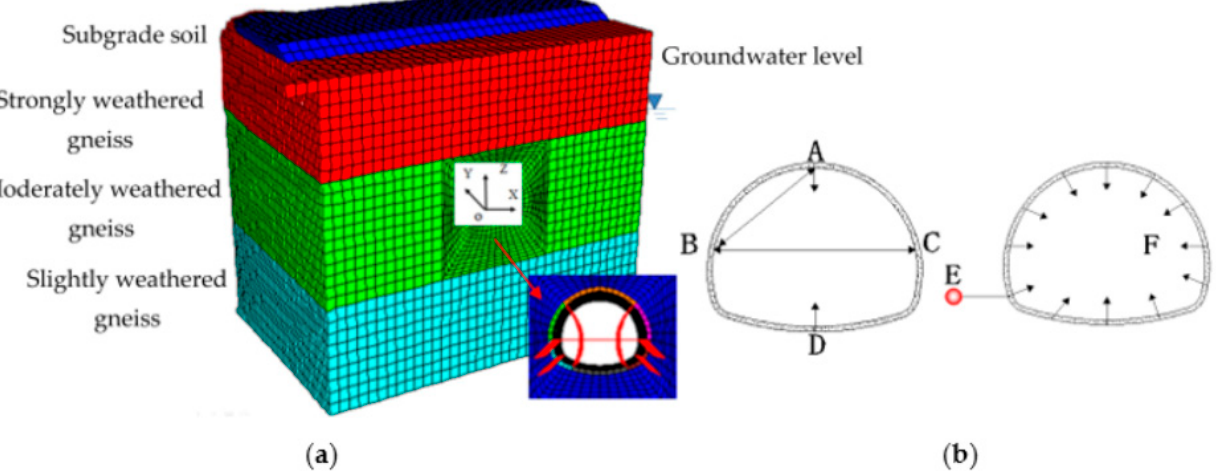
Figure 3. The numerical calculation model of the Chenjiadian tunnel. ( a ) Numerical model. ( b ) Distribution of monitoring points.